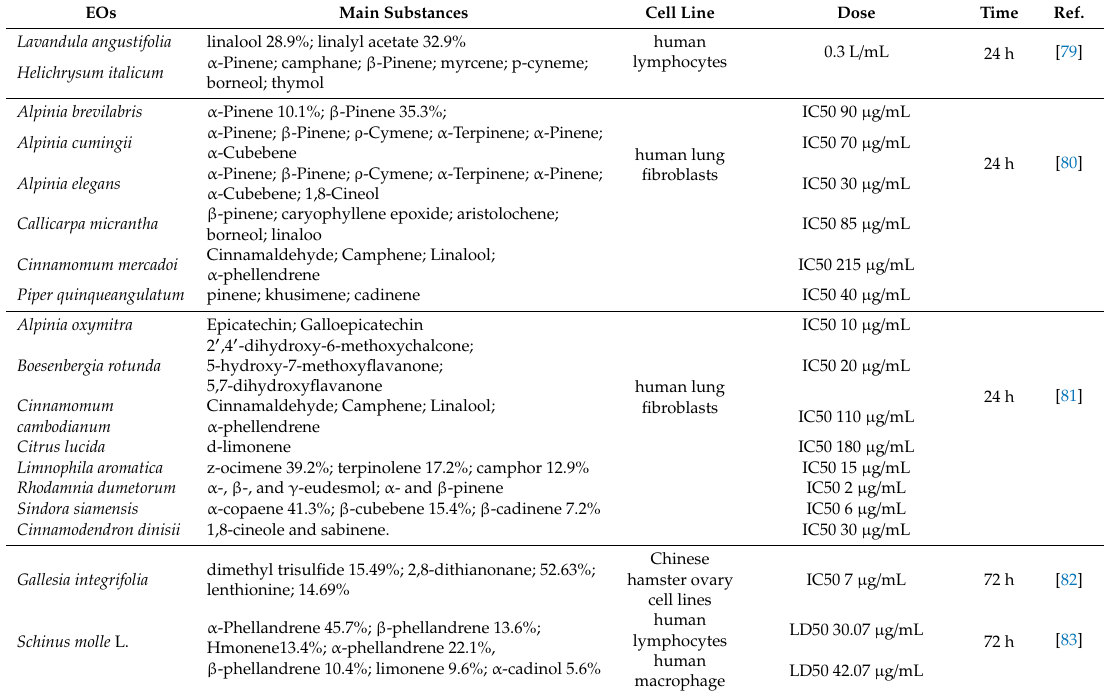
Table 1. Cytotoxic e ff ects of EOs (essential